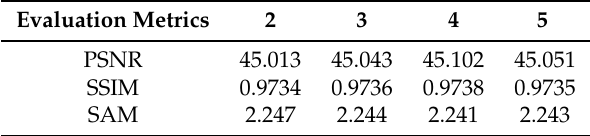
Table 1. Analysis of the influence of the number of the mixed convolutional module D on the